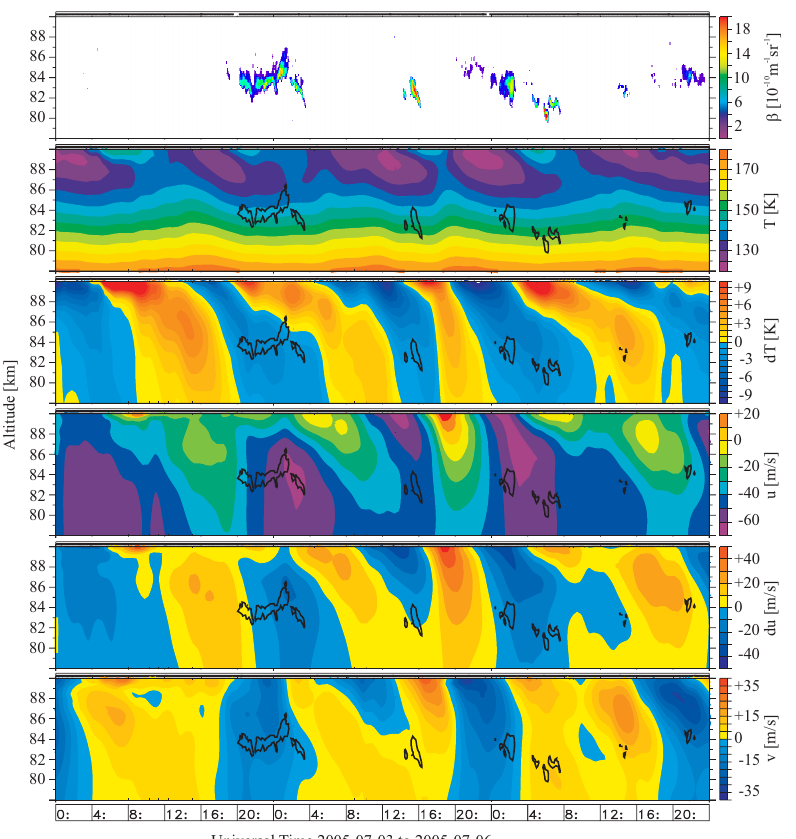
Fig. 6. Time series for NLC (measured by RMR-lidar) and atmospheric parameters (calculated by LIMA-model) for three consecutive days (3–5 July 2005) above ALOMAR. From top to bottom: NLC brightness in terms of volume backscatter coefficient, temperature, temperature deviation, zonal wind, zonal wind deviation, and meridional wind. Deviations are calculated with respect to the mean profiles over the whole time period. NLC contours for a brightness of β max = 4 are plotted on top of the LIMA results. At 83km the mean values (ranges) for temperature, zonal wind and meridional wind are about: 148K ( ± 4K), − 44m/s ( ± 18m/s), − 0 . 5m/s ( ±